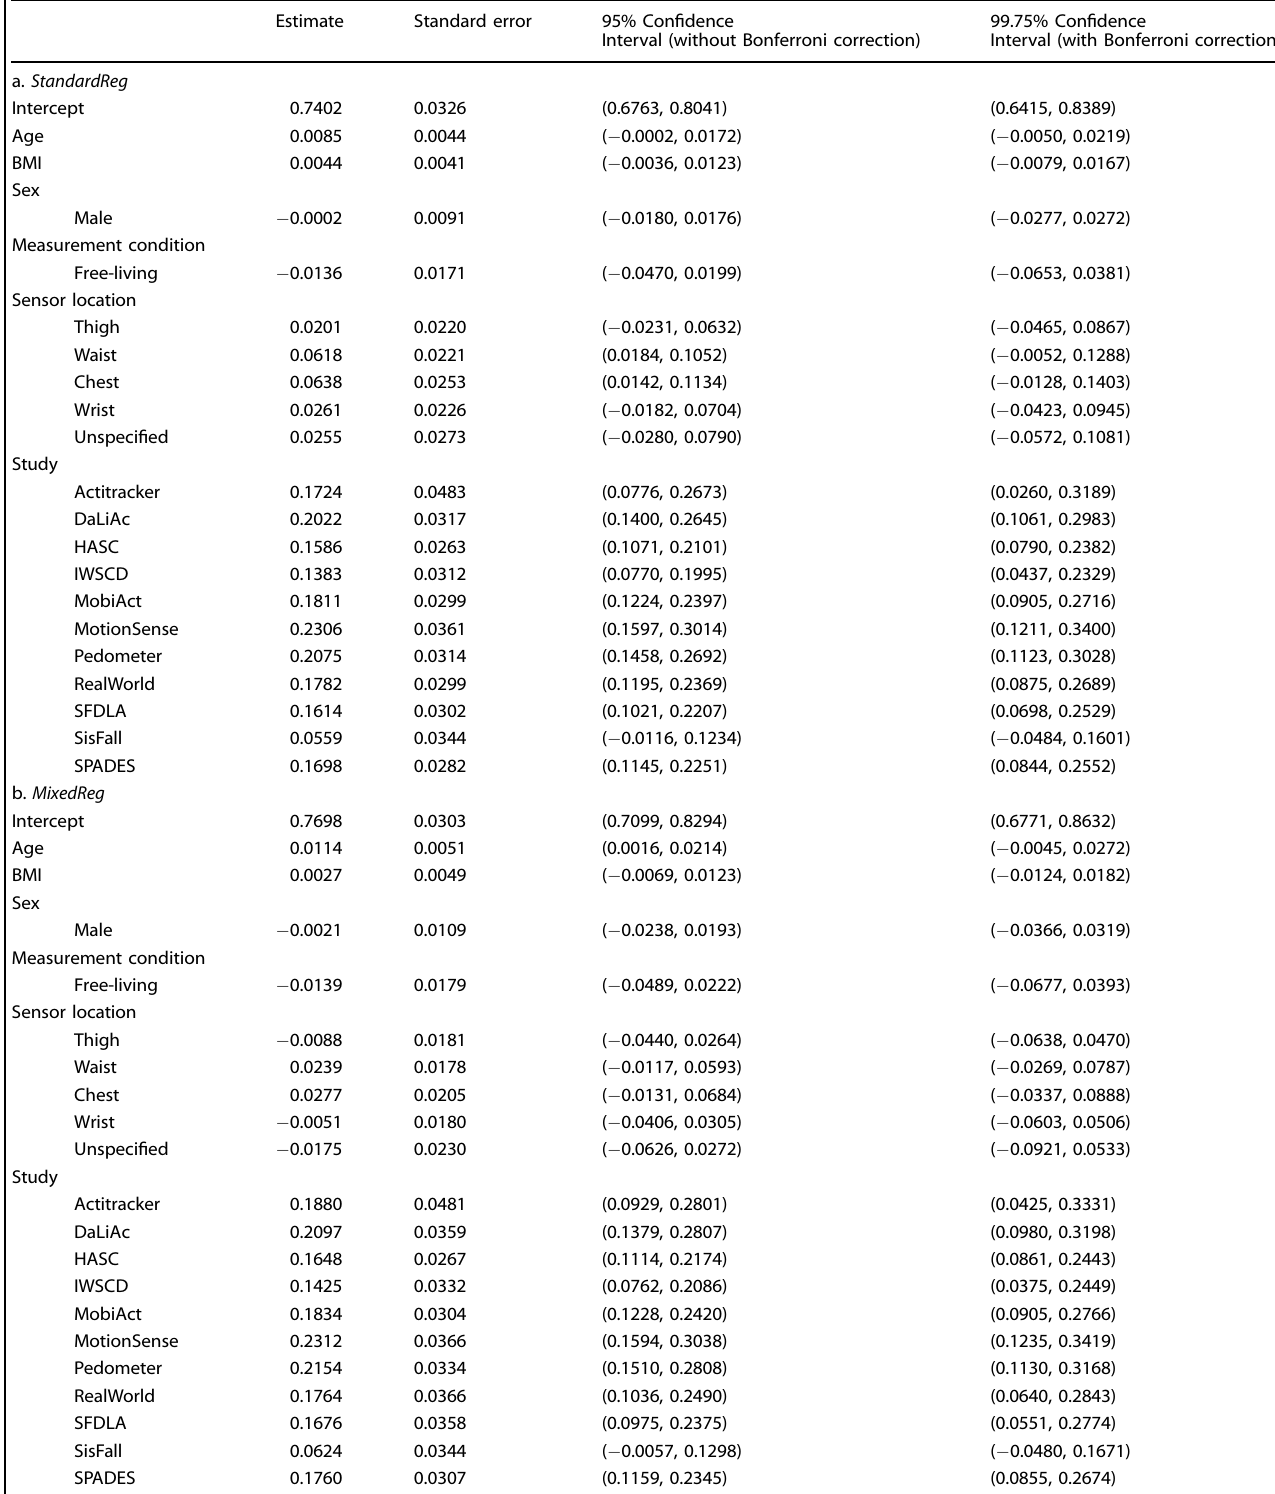
Table 3. Bias model